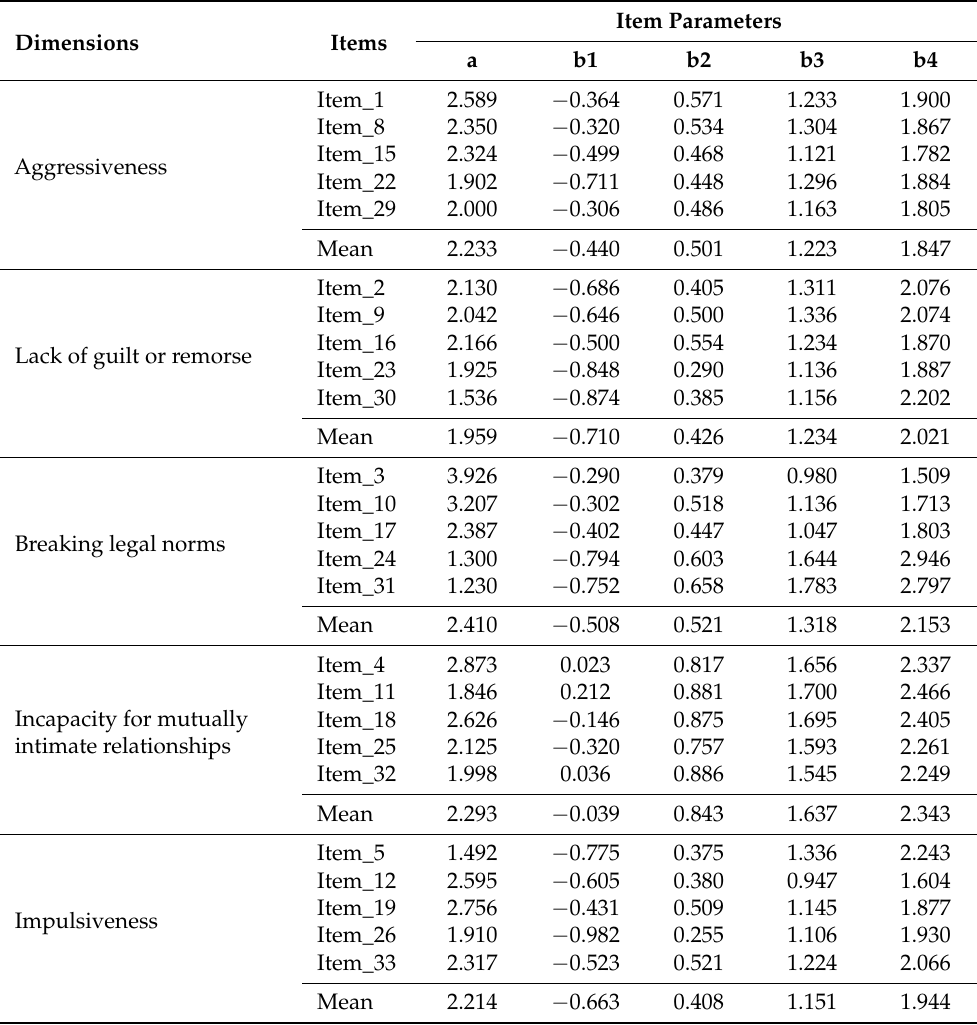
Table 9. Discrimination and threshold parameters for the Graded Response